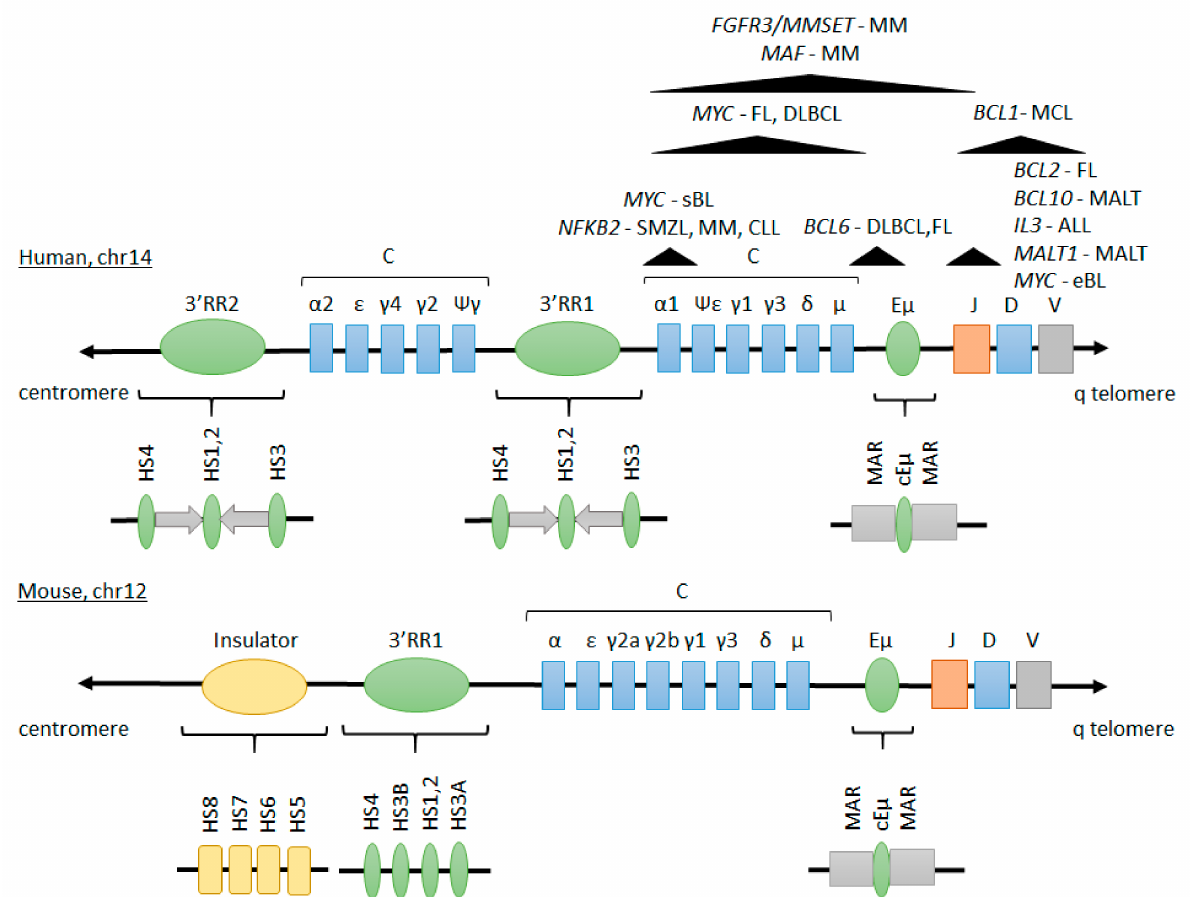
Figure 1. IGH locus organization in human and mice. Black triangles mark regions of breakpoints involved in translo- cations in malignant cells. C—constant region; J—joining; D—diversity; V—variable; HS—DNase hypersensitive site; MAR—matrix attachment region; 3 (cid:48) RR—3 (cid:48) regulatory region; ALL, acute lymphoblastic leukemia; eBL, endemic Burkitt lymphoma; sBL, sporadic Burkitt lymphoma; CLL, chronic lymphocytic leukemia; DLBCL, diffuse large B-cell lymphoma; FL, follicular lymphoma; MALT, mucosa-associated lymphoid tissue; MCL, mantle cell lymphoma; MM, multiple myeloma; SMZL, splenic marginal zone B-cell